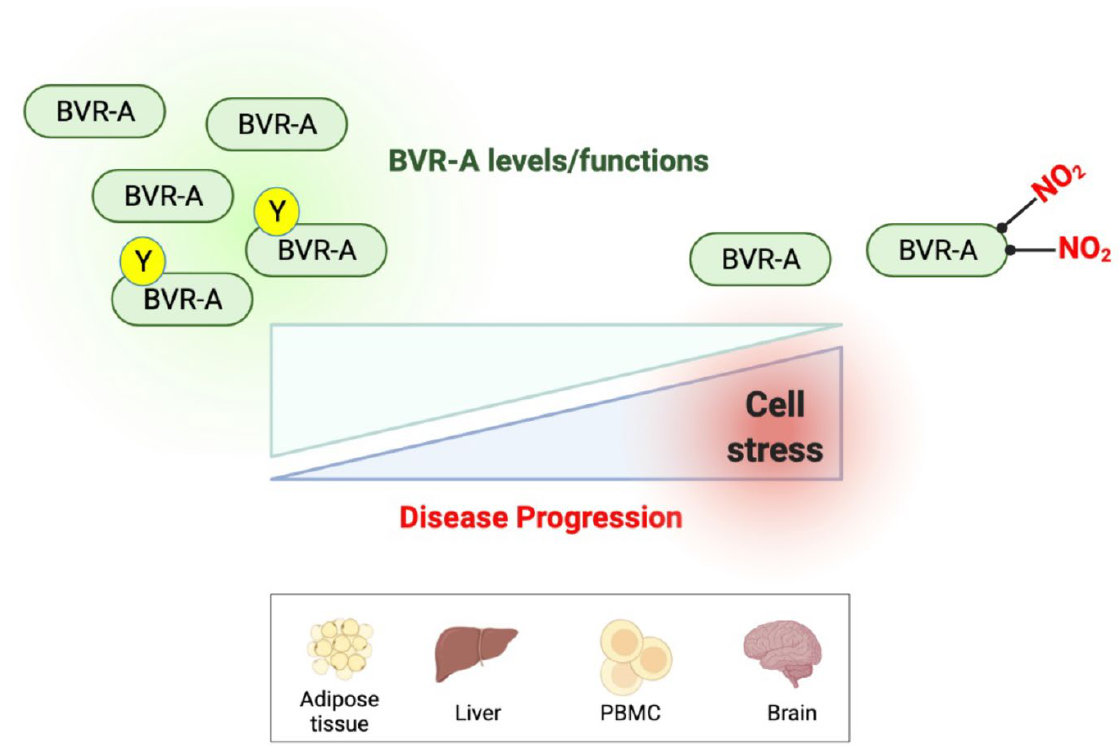
Figure 3. Reduced BVR-A protein levels or impaired BVR-A activation occur with the progression of metabolic or neurodegenerative diseases. Reduced BVR-A protein levels or impaired BVR-A activation (reduced Tyr phosphorylation or increased nitration) are observed during the progression of either metabolic or neurodegenerative diseases and are associated with the dysfunction of insulin signaling.